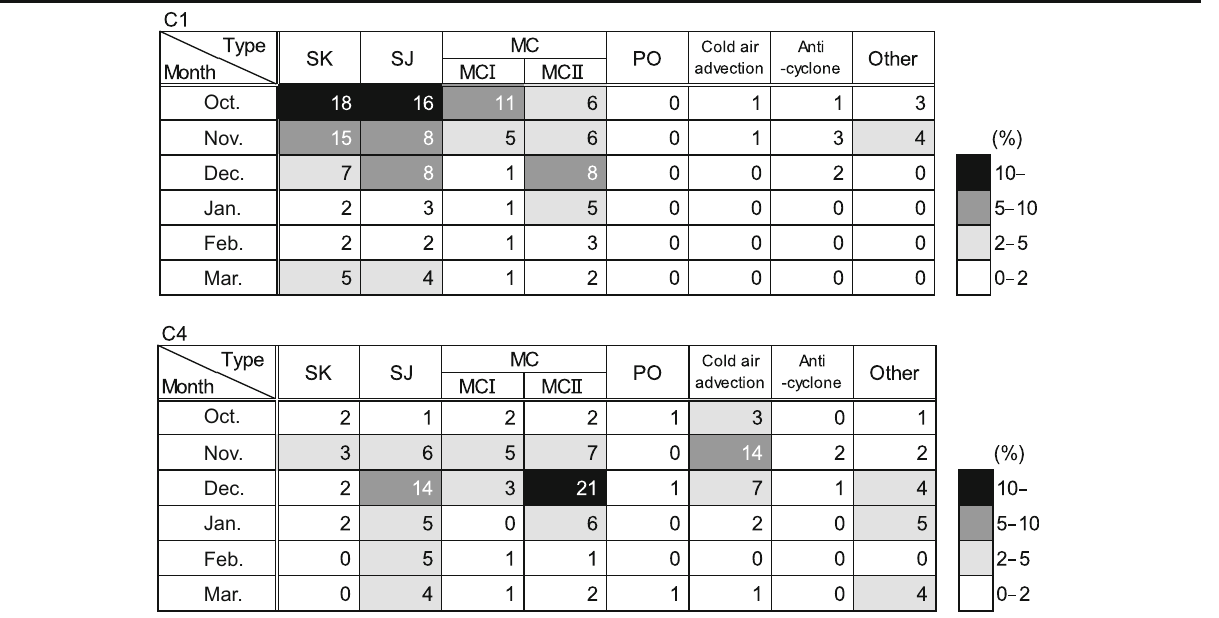
Table 2 Numbers of cases in categories C1 and C4 grouped by month and atmospheric conditions. Cell color shows relative frequency